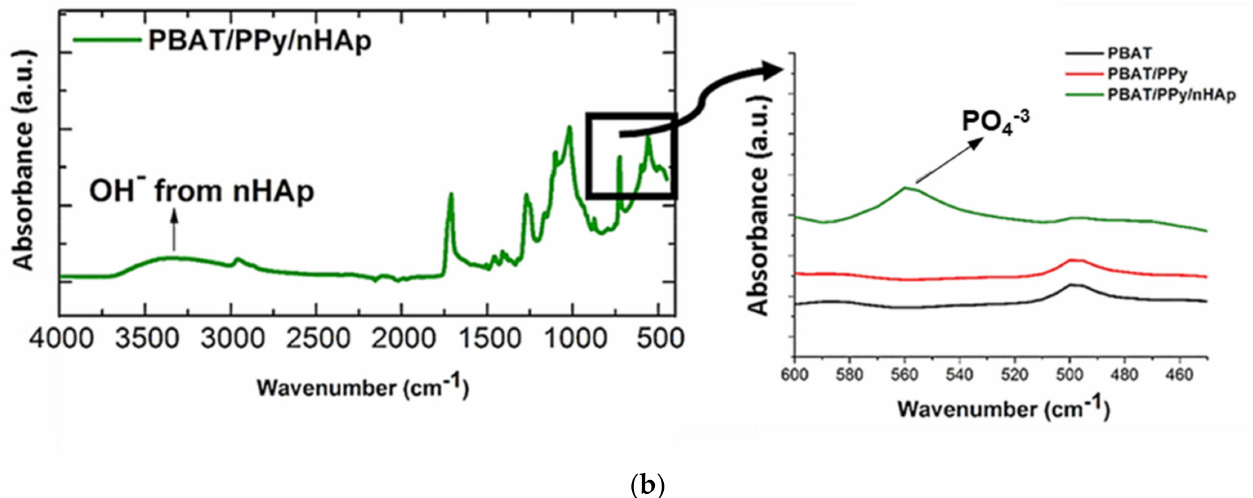
Figure 4. ( a ) FE-SEM micrographs of nHAp crystals electrodeposited onto the PBAT/PPy scaffold surface (scale bar indicates 2.5 µ m); ( b ) ATR-FTIR spectra of PBAT/PPy/nHAp indicating the absorption of OH – (vibrational band in the 3500 cm − 1 range) and PO 4 − 3 (absorption peak at 566 cm − 1 ). Reproduced with permission from ref. [68]. Copyright 2016 The Royal Society of Chemistry.